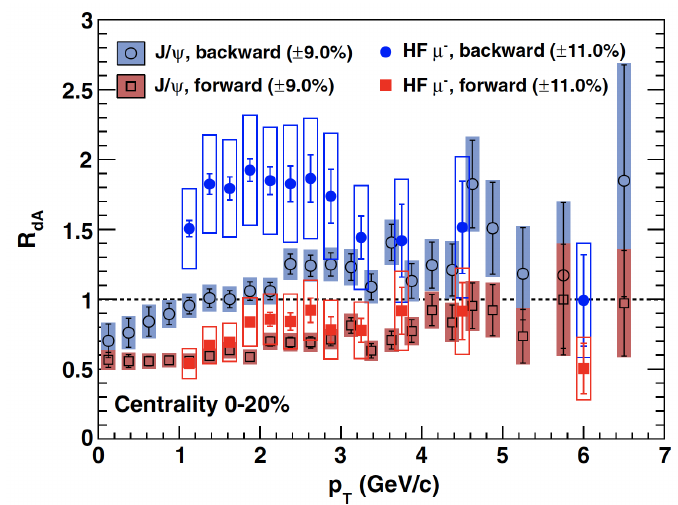
Figure 5. The J / ψ nuclear modification factor (filled symbols) compared with heavy flavor muons (open symbols) in d + Au collisions at 0–20% centrality [33]. The red (blue) data points correspond to forward (backward) rapidity measurements. Reprinted with permission from American Physi- cal Society.